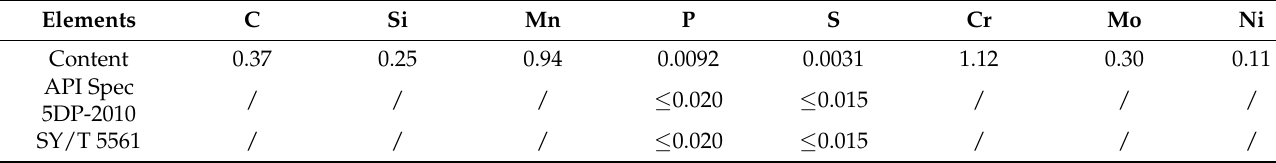
Table 1. Drill pipe joint chemical composition test results (wt,